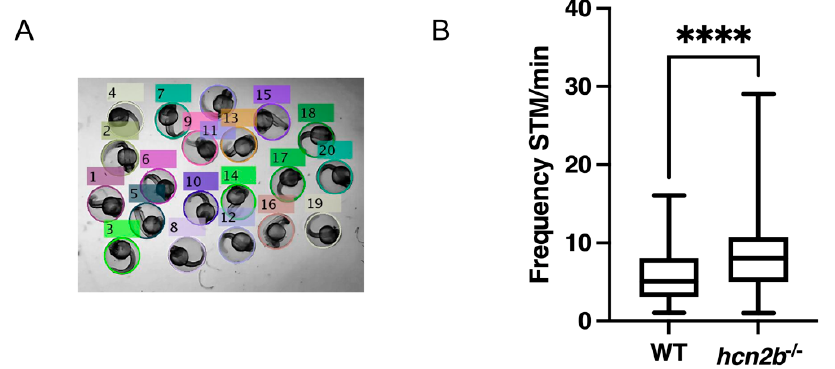
Figure 3. Spontaneous tail movement. ( A ) Twenty-four hours post-fertilization zebrafish larvae in a glass slide; tagged and numbered by MATLAB application ZebraSTM [27]. ( B) Frequency of spontaneous tail movements (STM) per one minute of WT versus hcn2b − / − zebrafish mutant. Homozygous hcn2b mutants showed 1.5 times more tail movements compared to WT. Asterisk indicate statistical significance compared to the control, p < 0.0001 (****).